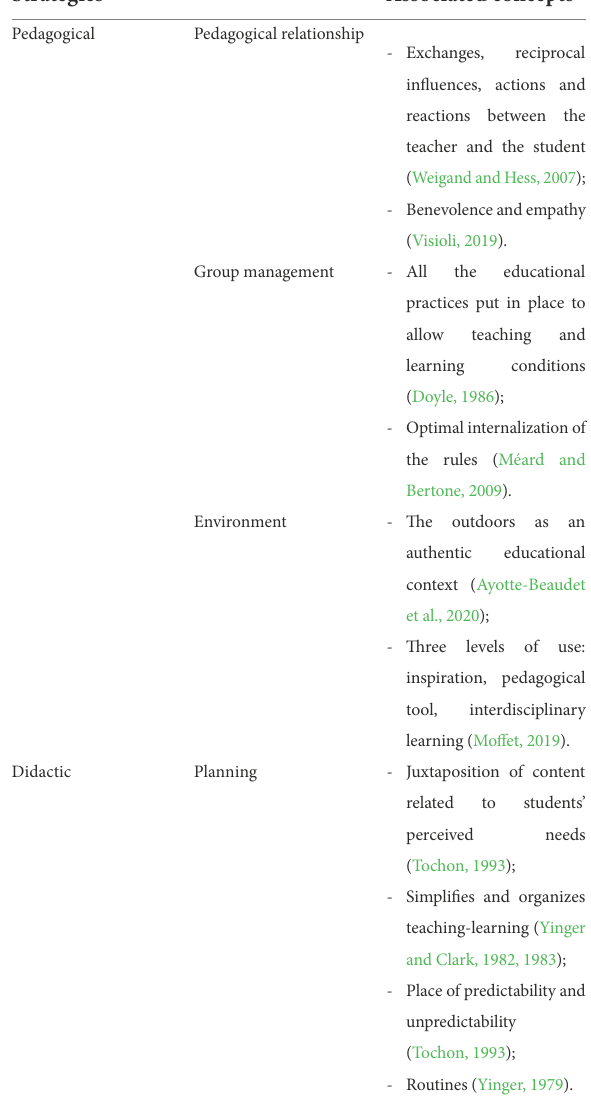
TABLE 2 Synthesis of the teaching strategies (pedagogical and didactic) used in this study and associated concepts.